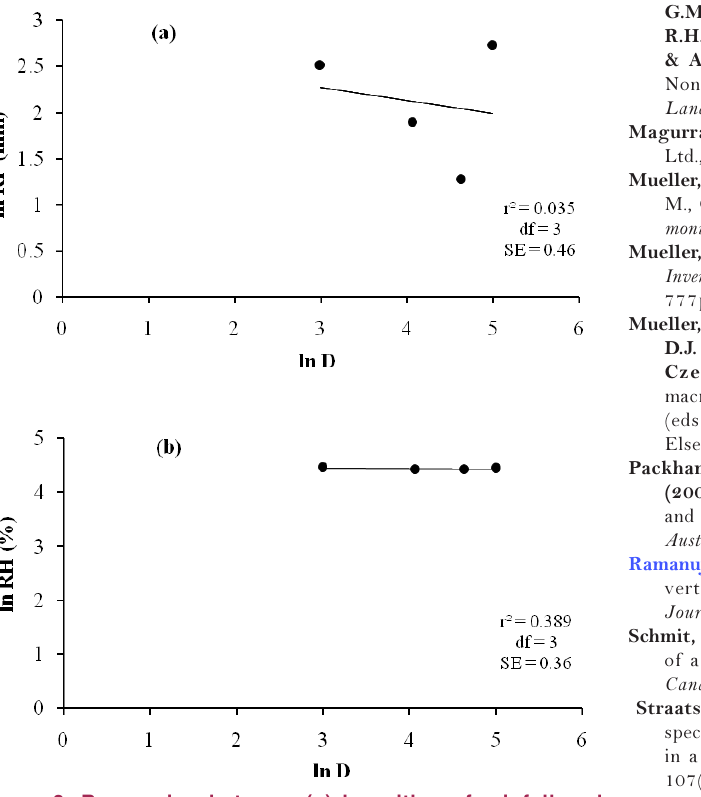
3. Regression between (a) logarithm of rainfall and logarithm density, and (b) logarithm of relative humidity and logarithm density. Each dot corresponds to total of individuals from the collection periods (4 months). RF – Relative rainfall; RH – Relative humidity; D – species density; df – degree of freedom; SE - Standard